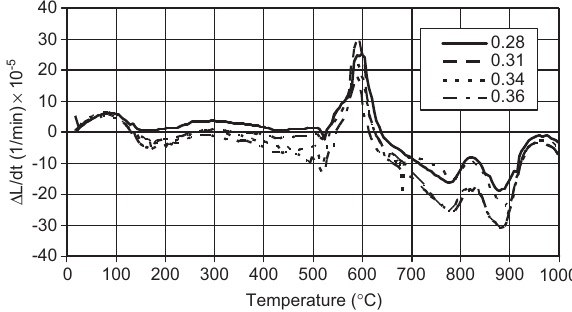
Figure 10 The first derivation of thermal strain curve of SCLC with diatomite.